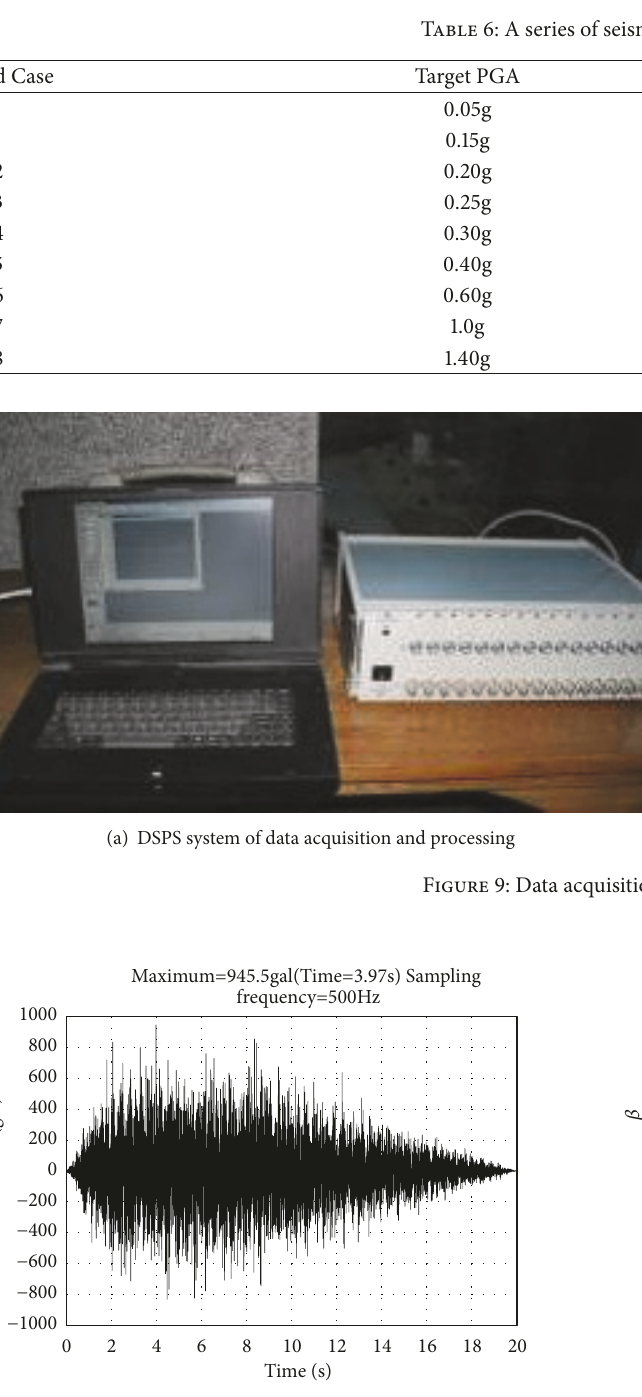
Figure 11: Response spectrum of Chinese Code seismic